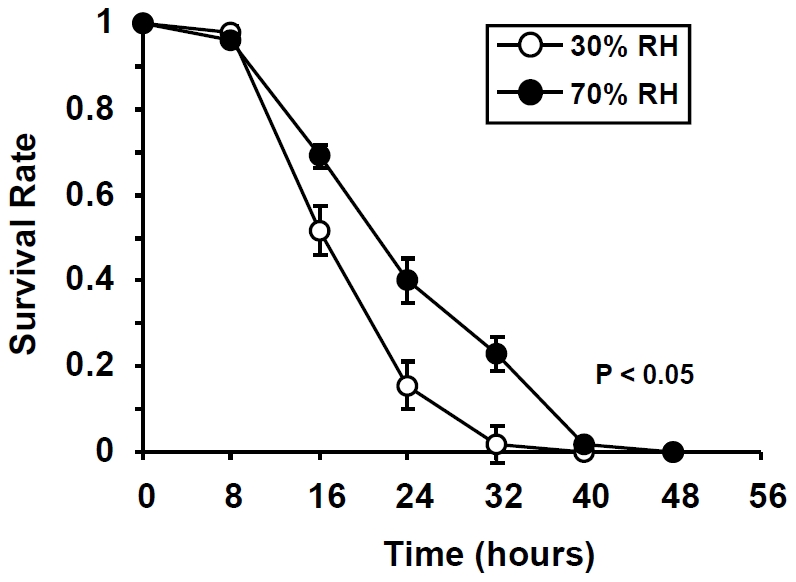
Survival of An. gambiae mosquitoes under desiccation stress.Four-day old female mosquitoes were exposed to 70% (black circle) or 30% (white circle) relative humidity without access to water or sugar. The number of dead mosquitoes was recorded every 8 hours until all died. Data represent means ± SEM for n = 10 independent replicates.